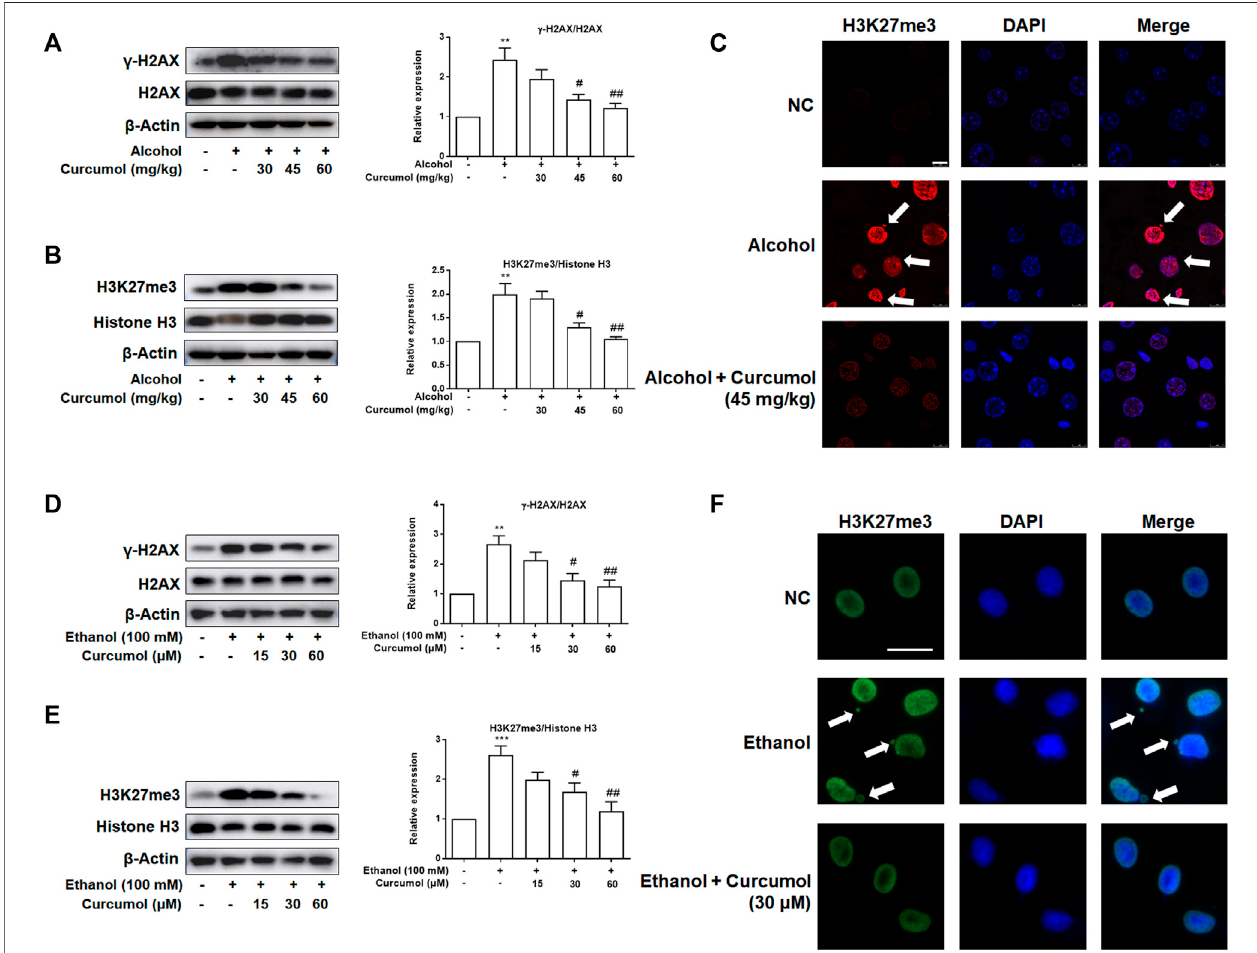
FIGURE3| Curcumol reducedethanol-induced CCFformation. (A and B) WesternblotanalysesoftheclassicalmarkersofCCF( γ -H2AXandH3K27me3)protein levels in vivo , n = 3. Data are represented as mean ± SD. Signi fi cance: ** p < 0.01 versus control group, # p < 0.05 and ## p < 0.01 versus alcohol group. (C and F) Representativeimages ofimmuno fl uorescenceanalyses ofH3K27me3inmice ’ slivertissues (scarebar,7.5 μ m)andLO2 cells(scarebar,50 μ m).CCFaremarkedwith arrows, n = 3. (D and E) Western blot analyses of the classical markers of CCF ( γ -H2AX and H3K27me3) protein levels in vitro , n = 3. Data are represented as mean ± SD. Signi fi cance: ** p < 0.01 and *** p < 0.001 versus control group, # p < 0.05 and ## p < 0.01 versus ethanol group.